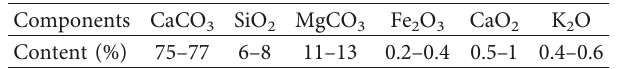
Table 6: Chemical component of limestone